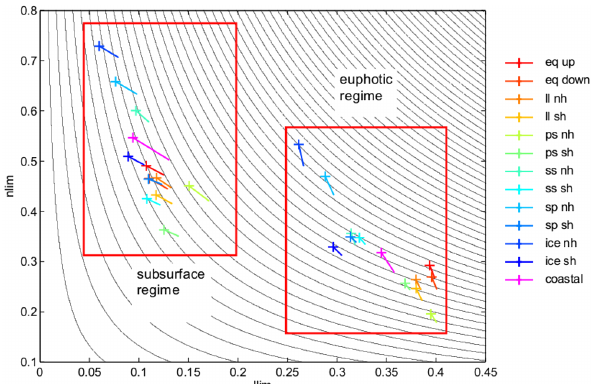
Figure 15. All vectors from Fig. 14c and d, on the same plot. Vec- tors for nlim, llim values averaged over the upper 10m occupy the “euphotic regime” and values averaged over the upper 200m oc- cupy the “subsurface